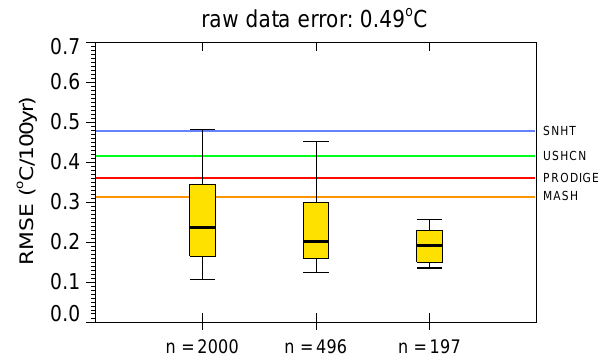
Figure 3. The same as Fig. 2, but for trend biases in network mean series.